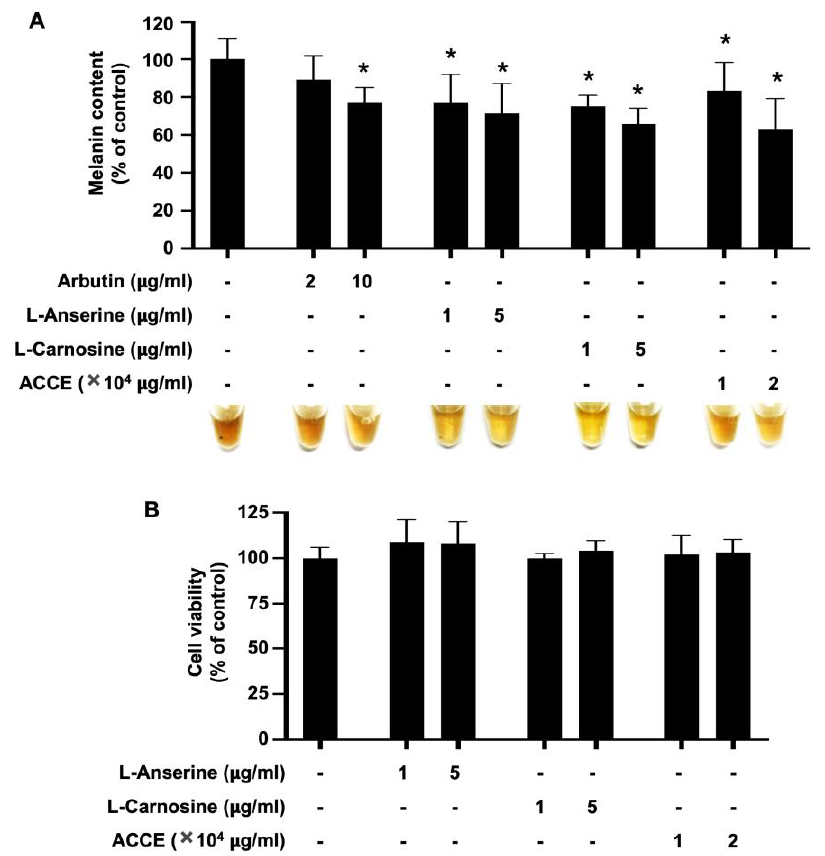
Figure 4 . Effect of L-anserine, L-carnosine, and ACCE on melanin production in MNT-1 cells. ( A ) Melanin content in MNT-1 cells was measured at 72 h after treatment with 2 and 10 µg/mL of Arbutin, 1 and 5 µg/mL of L-anserine or L-carnosine, and 1.0 × 10 4 and 2.0 × 10 4 μ g/mL of ACCE. ( B ) Cell viability of MNT-1 cells was measured at 72 h after treatment with ACCE using MTT assay. Star (*) represents p < 0.05 by Student’s t -test.